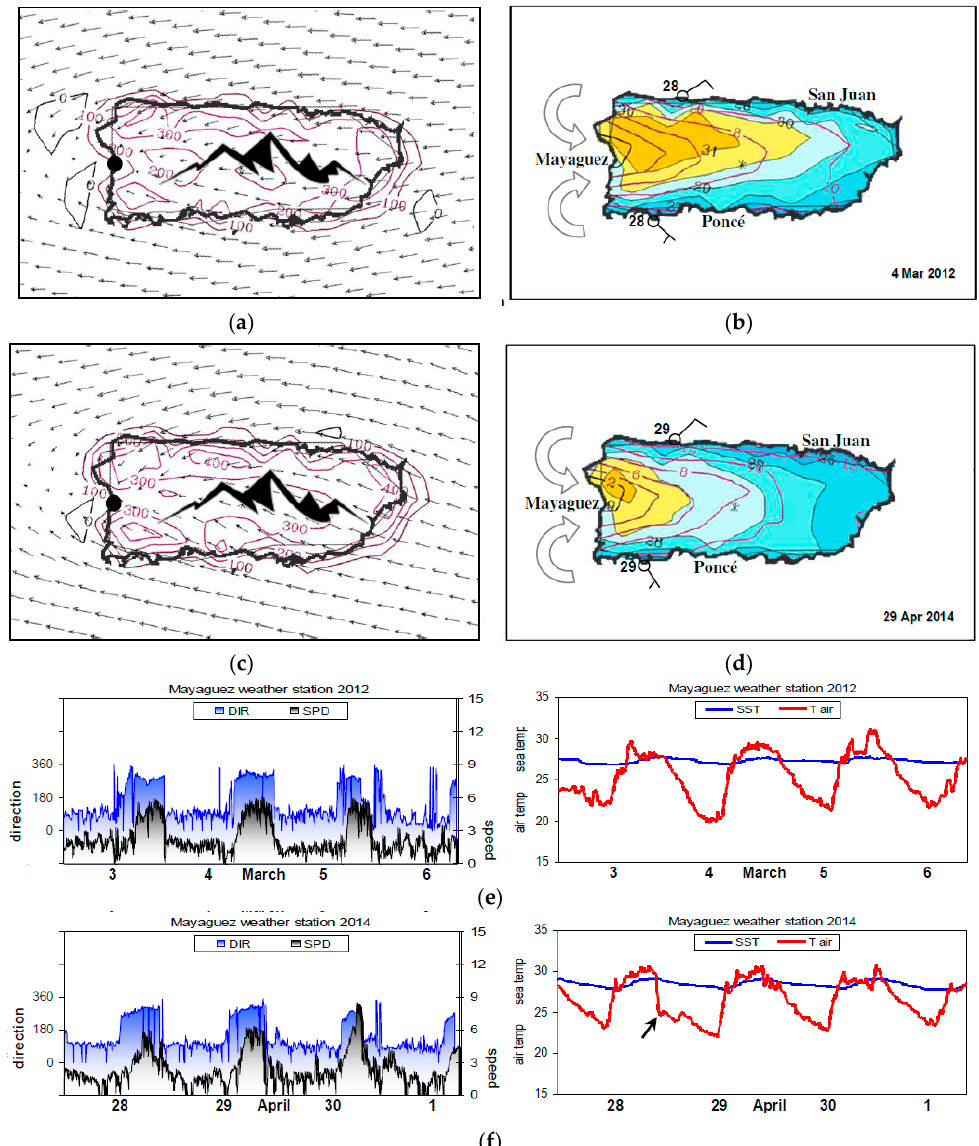
Figure 9. Puerto Rico area NAM 14:00 surface fields ( a , b ) 4 March 2012 and ( c , d ) 29 April 2014 of wind vectors and SHF with mountain icon (left); wind speed (contour, kt) and air temperature (shaded, ° C) with ocean area masked, place names, two station plots, and schematic wind rotors. ( e , f ) Mayaguez weather station data (dot in ( a , c )) during the two events: winds (left, m/s) and temperatures ( ° C). Arrow in ( f ) points to rain cooling.